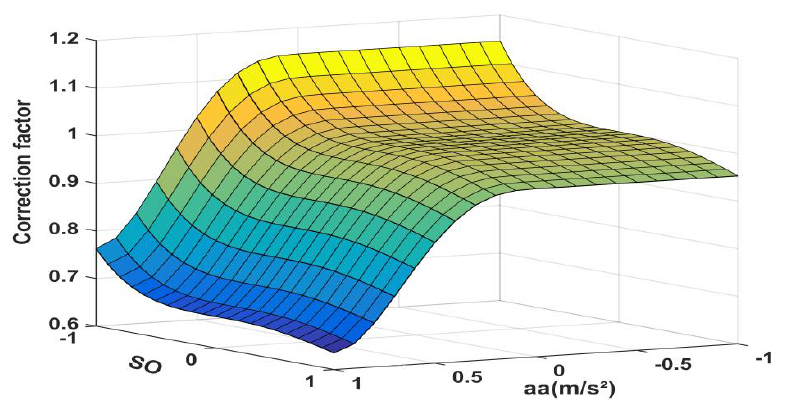
Figure 9. Optimal correction factor MAP with di ff erent accelerations and SOCs.